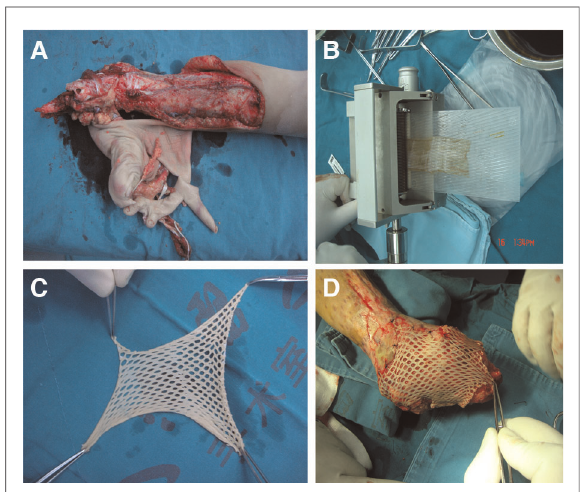
FIGURE 1 Split-thickness skin grafts meshing. ( A ) A severe juvenile lower extremity avulsion injury. ( B ) Graft meshing using a peeler. ( C ) Split-thickness skin grafts that has been meshed. ( D ) To cover the graft on the wound